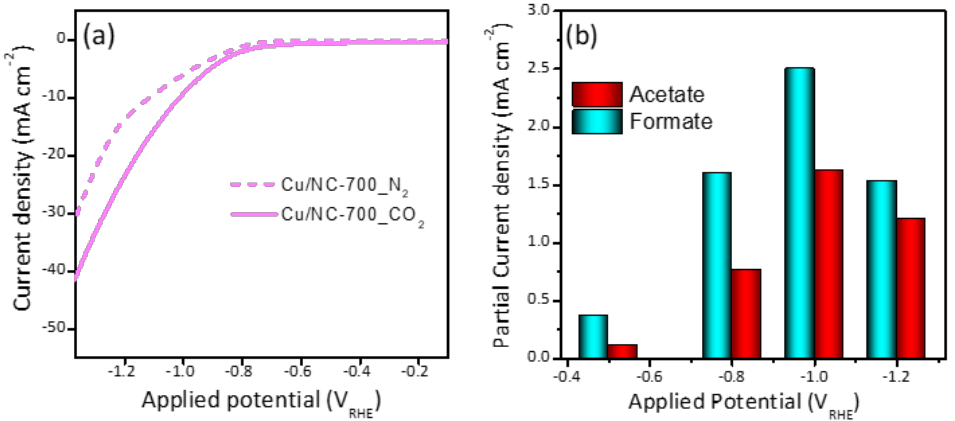
Figure 5. ( a ) LSV curves of Cu-NP/NC-700 electrocatalysts in N 2 and CO 2 saturated 0.5 M KHCO 3 electrolyte. ( b ) Partial current densities of Cu-NP/NC-700.